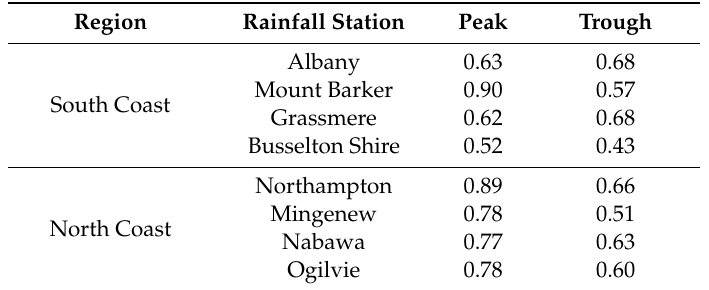
Table 8. Correlation coefficients (r) between observed and predicted peak and trough values.